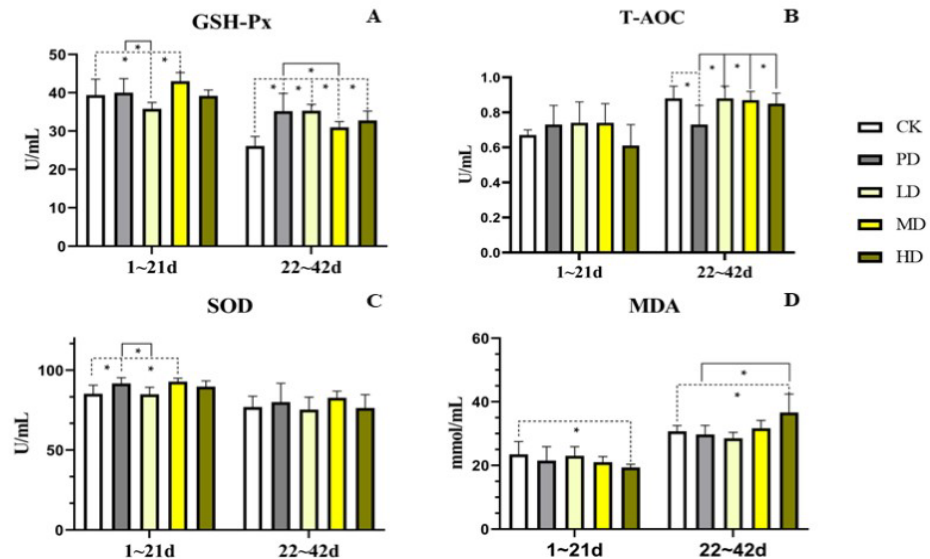
Figure 7. Effects of the fruit extract of K. coccinea on antioxidant function of white-feather broilers ( A ): Glutathione peroxidase (GSH-Px); ( B ): Total antioxidant capacity (T-AOC); ( C ): Superoxide dis- mutase (SOD); ( D ): malonaldehyde (MDA); Note: Dotted line: compare with CK group; Solid line: compare with PD group; * indicate significant differences between groups according to the Tukey test; Supplementary Materials Table S7.